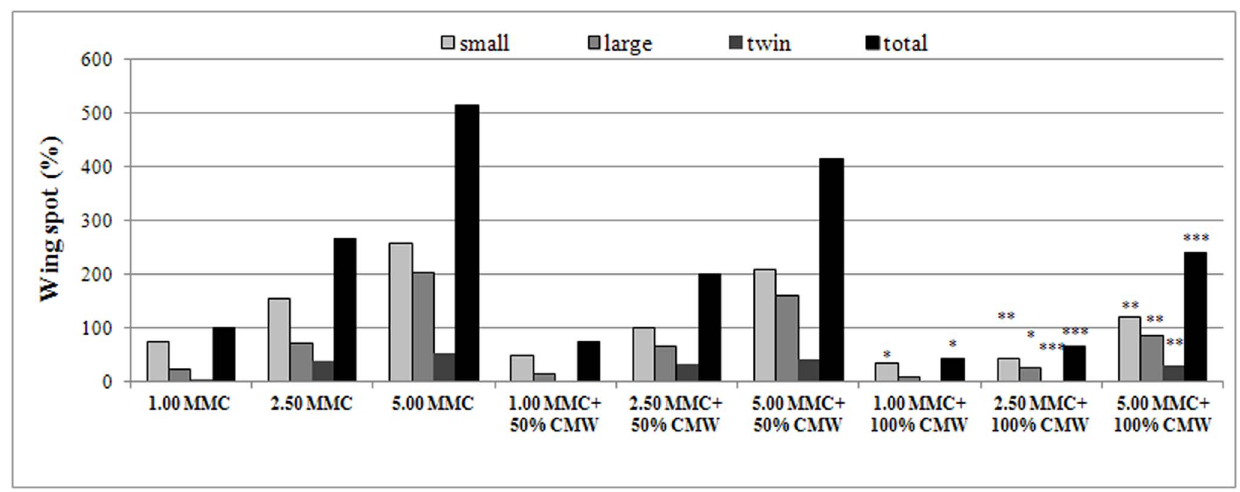
Figure 3. Wing spot frequency (%) induced by MMC (1.00, 2.50 and 5.00 m g/ml) in presence of CMW (50 and 100% v/v). [* p , 0.05, ** p , 0.01, *** p , 0.001, U-test].